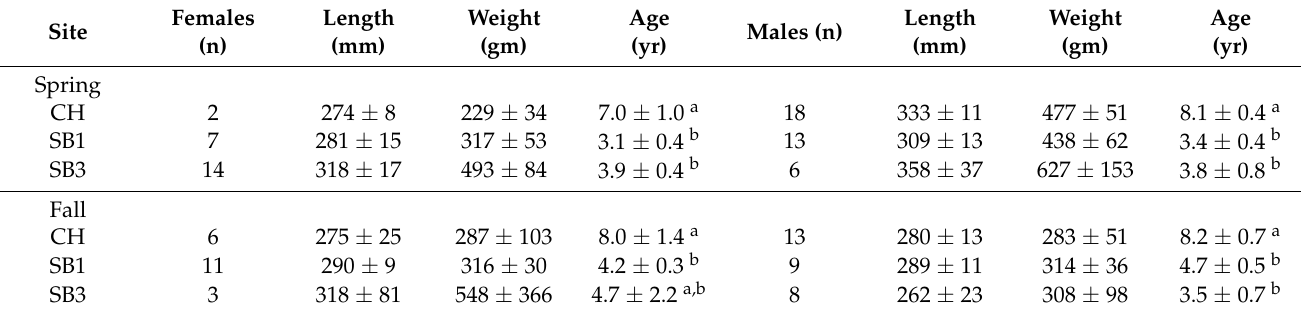
Table 2. Mean ( ± standard error) age and morphometric data (n = sample size, mm = millimeter, gm = grams) for adult smallmouth bass ( Micropterus dolomieu ) collected from the Cheat River (CH), South Branch Petersburg (SB1), and South Branch Moorefield (SB3) sites for spring and fall, 2019. Site comparisons made using Dunn’s Kruskal–Wallis multiple comparison test and p -values adjusted with the Holm method. Superscripts represent significant differences between